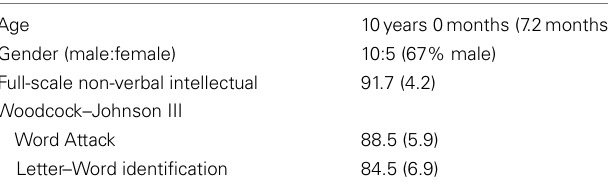
Table 1 | Demographic, cognitive and language characteristics of the participants .